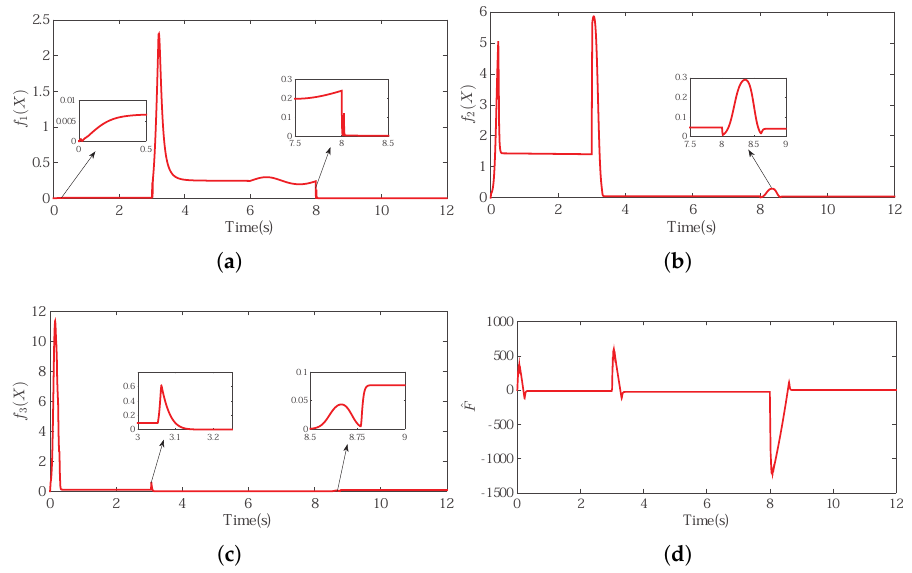
Figure 9. Adaptive estimation for unknown parameters. ( a ) The estimation of f 1 ( X ) ; ( b ) The estimation of f 2 ( X ) ; ( c ) The estimation of f 3 ( X ) ; ( d ) The estimation of load